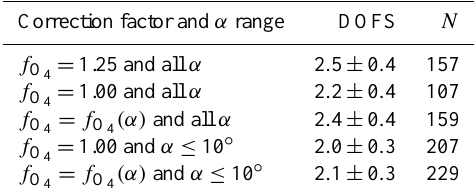
Table 2. DOFS and the number of available data ( N) for each case of correction